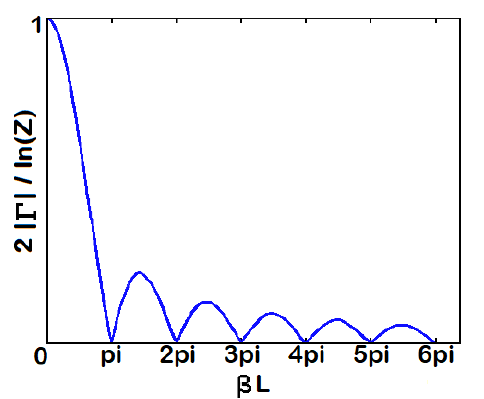
FIGURE 4. Reflection Coefficient of a Logarithmic Taper.